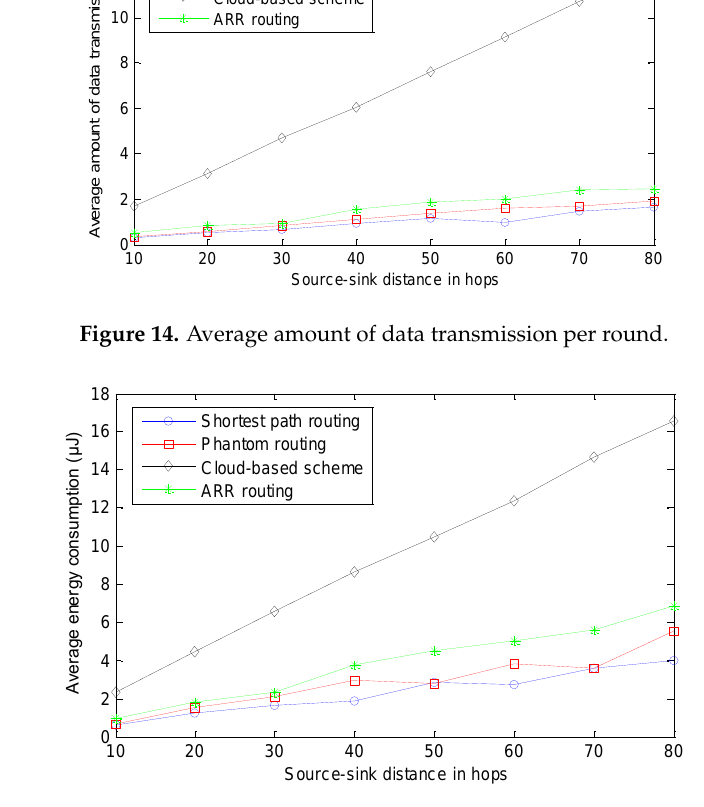
Figure 15. Average energy consumption per round.